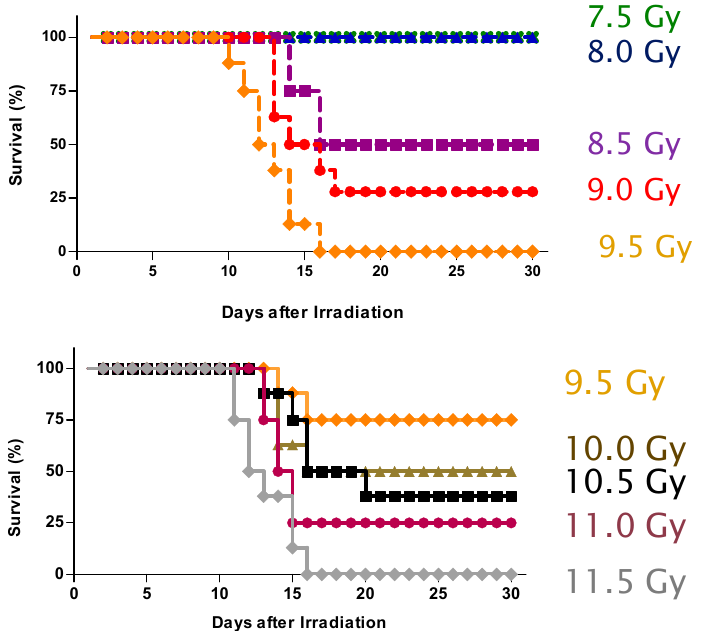
Figure 1. Opaganib protects against lethality from total body irradiation. Mice in the vehicle groups were exposed to 7.5, 8.0, 8.5, 9.0 or 9.5 Gy TBI ( Top Panel ), and mice in the opaganib-treated groups (100 mg/kg oral, 1 h prior to radiation) were exposed to 9.5, 10.0, 10.5, 11.0 or 11.5 Gy TBI ( Bottom Panel ). Survival was monitored for 30 days.